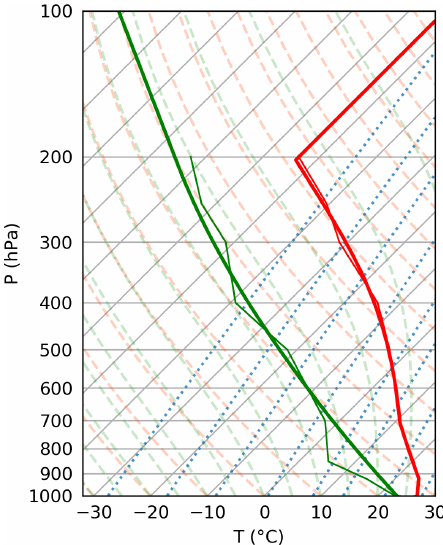
Figure 2. The thin lines show the observed sounding from Haikou station at 08:00LST, 25 September 2018. The thick lines show the smoothed sounding used to initialize the simulations. The red lines show the temperature and the green lines show the dew point tem- perature.